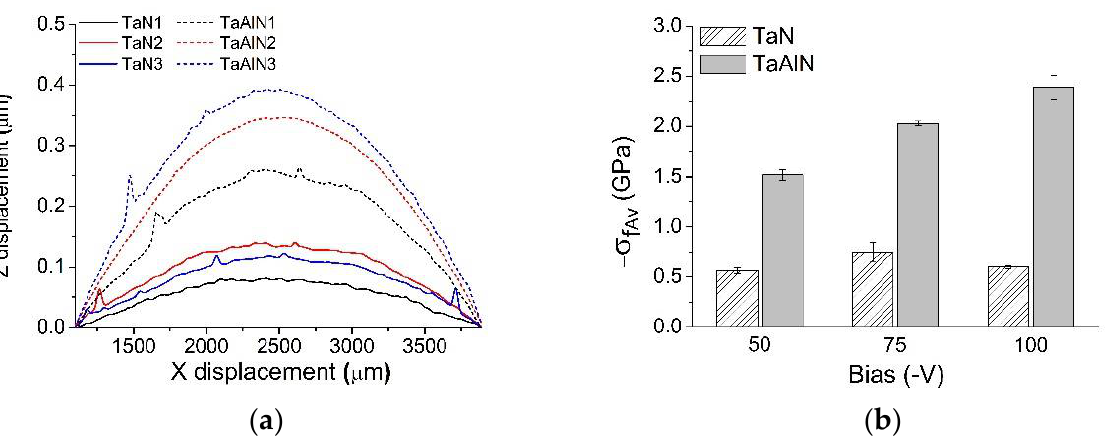
Figure 6. Residual stresses of the TaN and TaAlN coatings, measured by ( a ) the curvature method and ( b ) the Stoney equation.